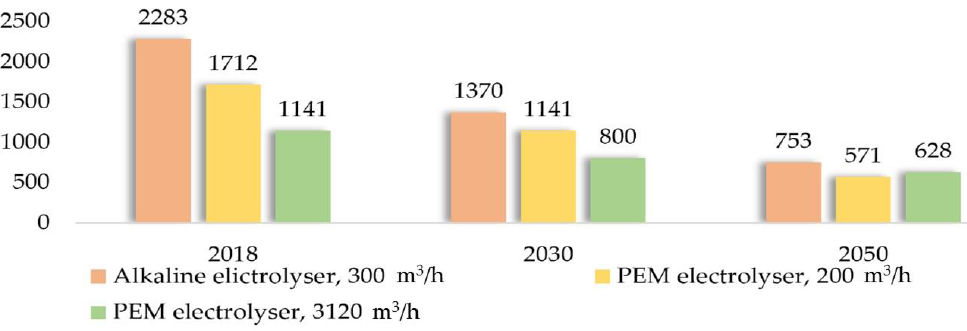
Figure 5. Cost of water electrolyzers’ capacity, USD per kW. Data from [24].